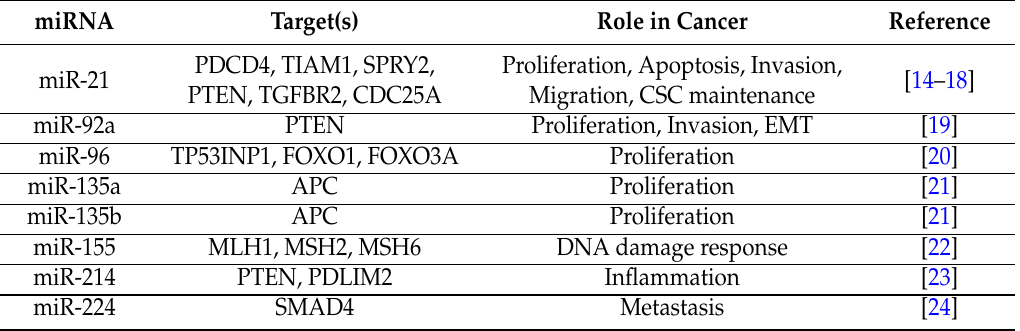
Table 1. Oncogenic miRNAs in CRC.